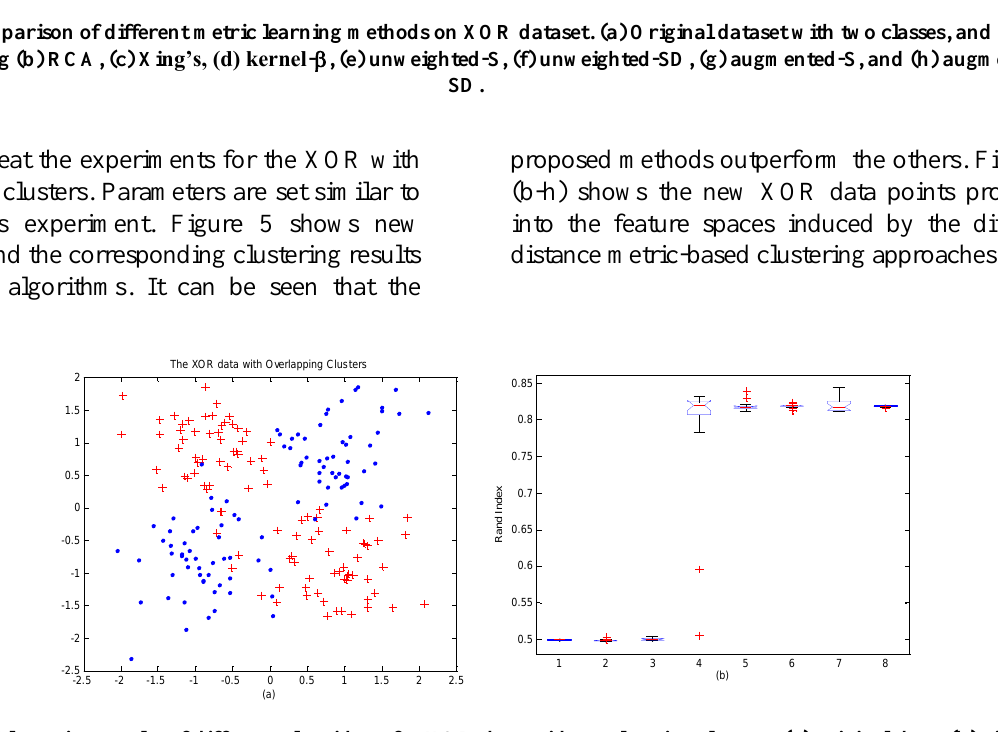
Figure 5. Clustering results of different algorithms for XOR data with overlapping clusters. (a) original data, (b) eight algorithms (numbered in Section 4.1) are as follow: (1) Euclidean, (2) RCA, (3) Xing’s, (4) kernel-  , (5) unweighted- S , (6) unweighted- SD , (7) augmented- S , and (8) augmented- SD